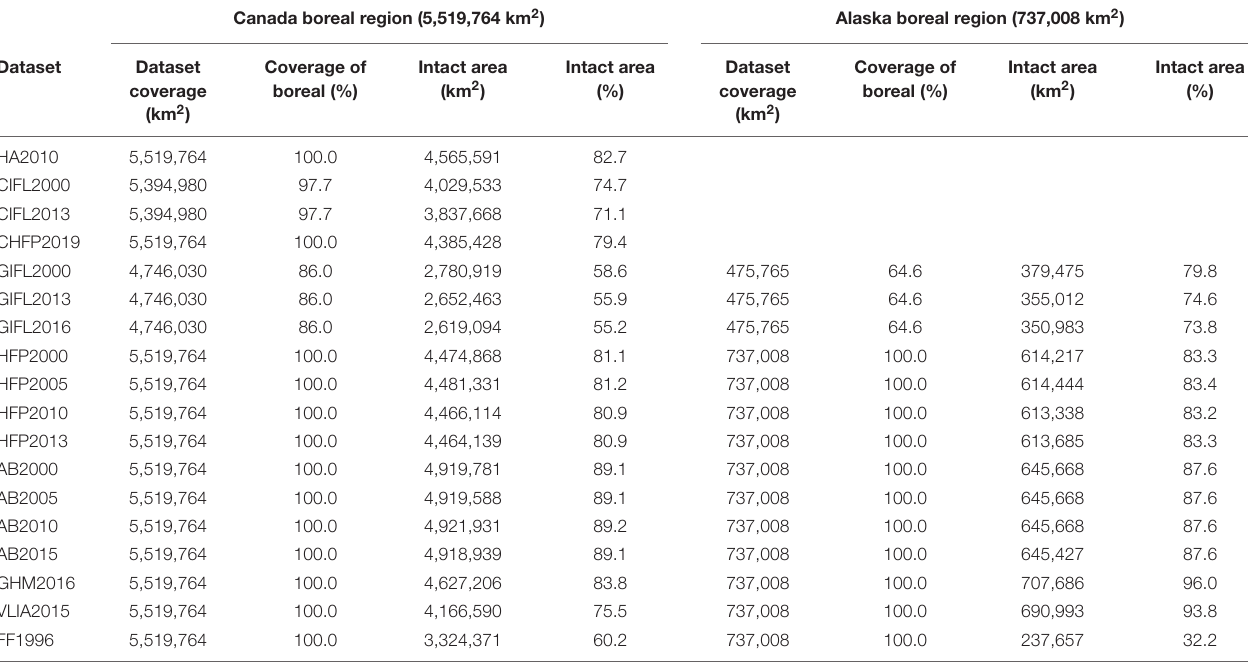
TABLE 3 | Comparison of the areal extent of dataset coverage within the boreal region and areas identified as being intact within each dataset.